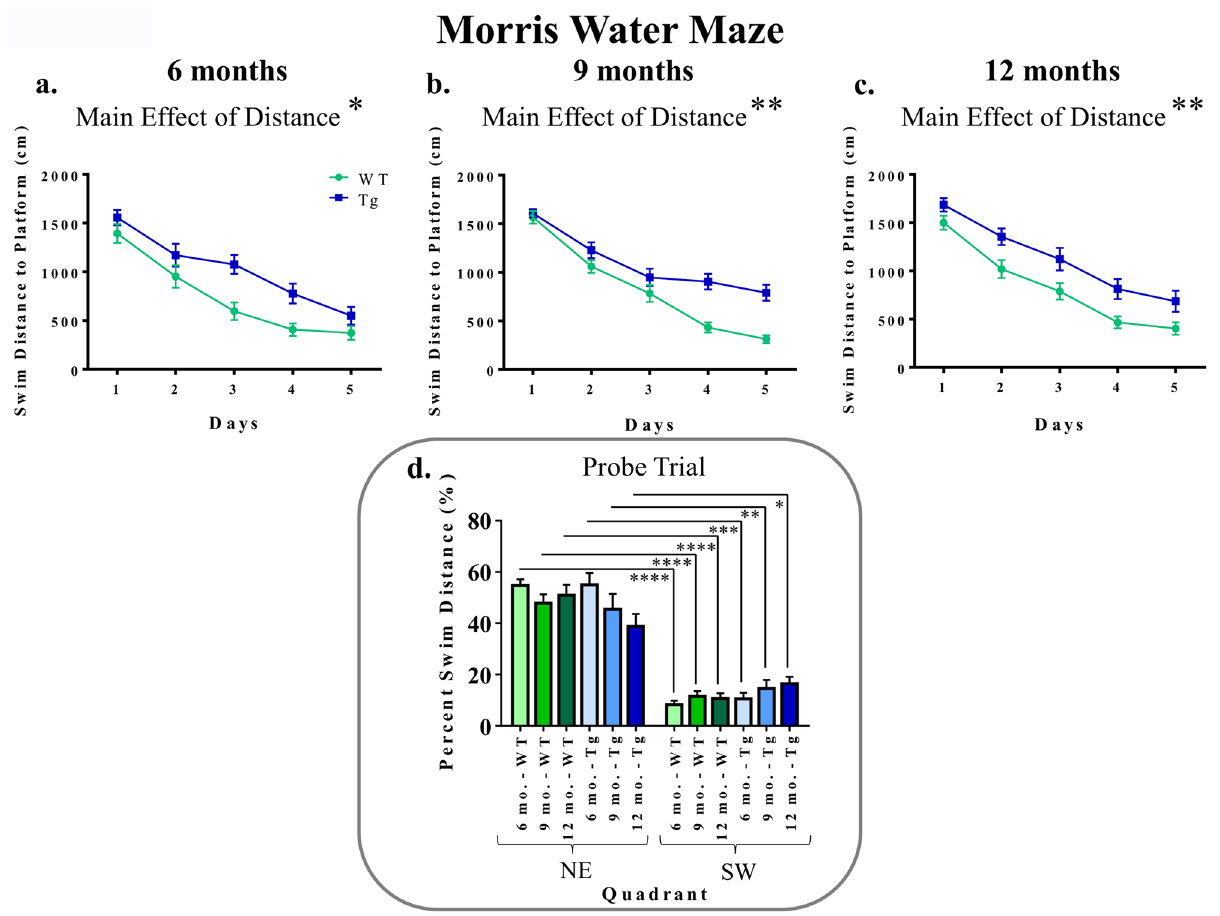
Figure 5. Reference memory performance as evaluated on the MWM: consistent deficits in TgF344-AD rats across each age for swim distance to the platform. ( a – c ) When evaluating swim distance to platform (cm) for each age-point across Days 1–5, there was a significant effect of Genotype, whereby Tg rats swam greater distances to locate the hidden platform than WT rats, indicating spatial reference memory impairment. * p < 0.05, ** p < 0.01. ( d ) For the probe trial, analyses of percent of total swim distance in the target quadrant (NE) as compared to the opposite quadrant (SW) for each group showed that all groups were successful in spatially localizing the platform by swimming a greater proportion of their total distance in the NE as opposed to the SW. * p < 0.05, ** p < 0.01, *** p < 0.001, **** p < 0.0001.